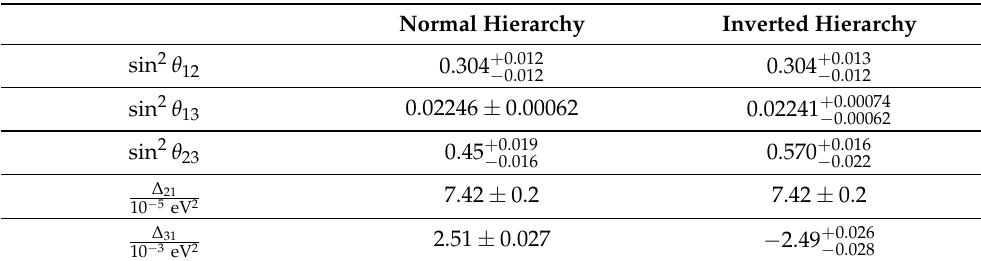
Table 1. Neutrino oscillation parameters determine by nu-fit collaboration using global neutrino oscillation data